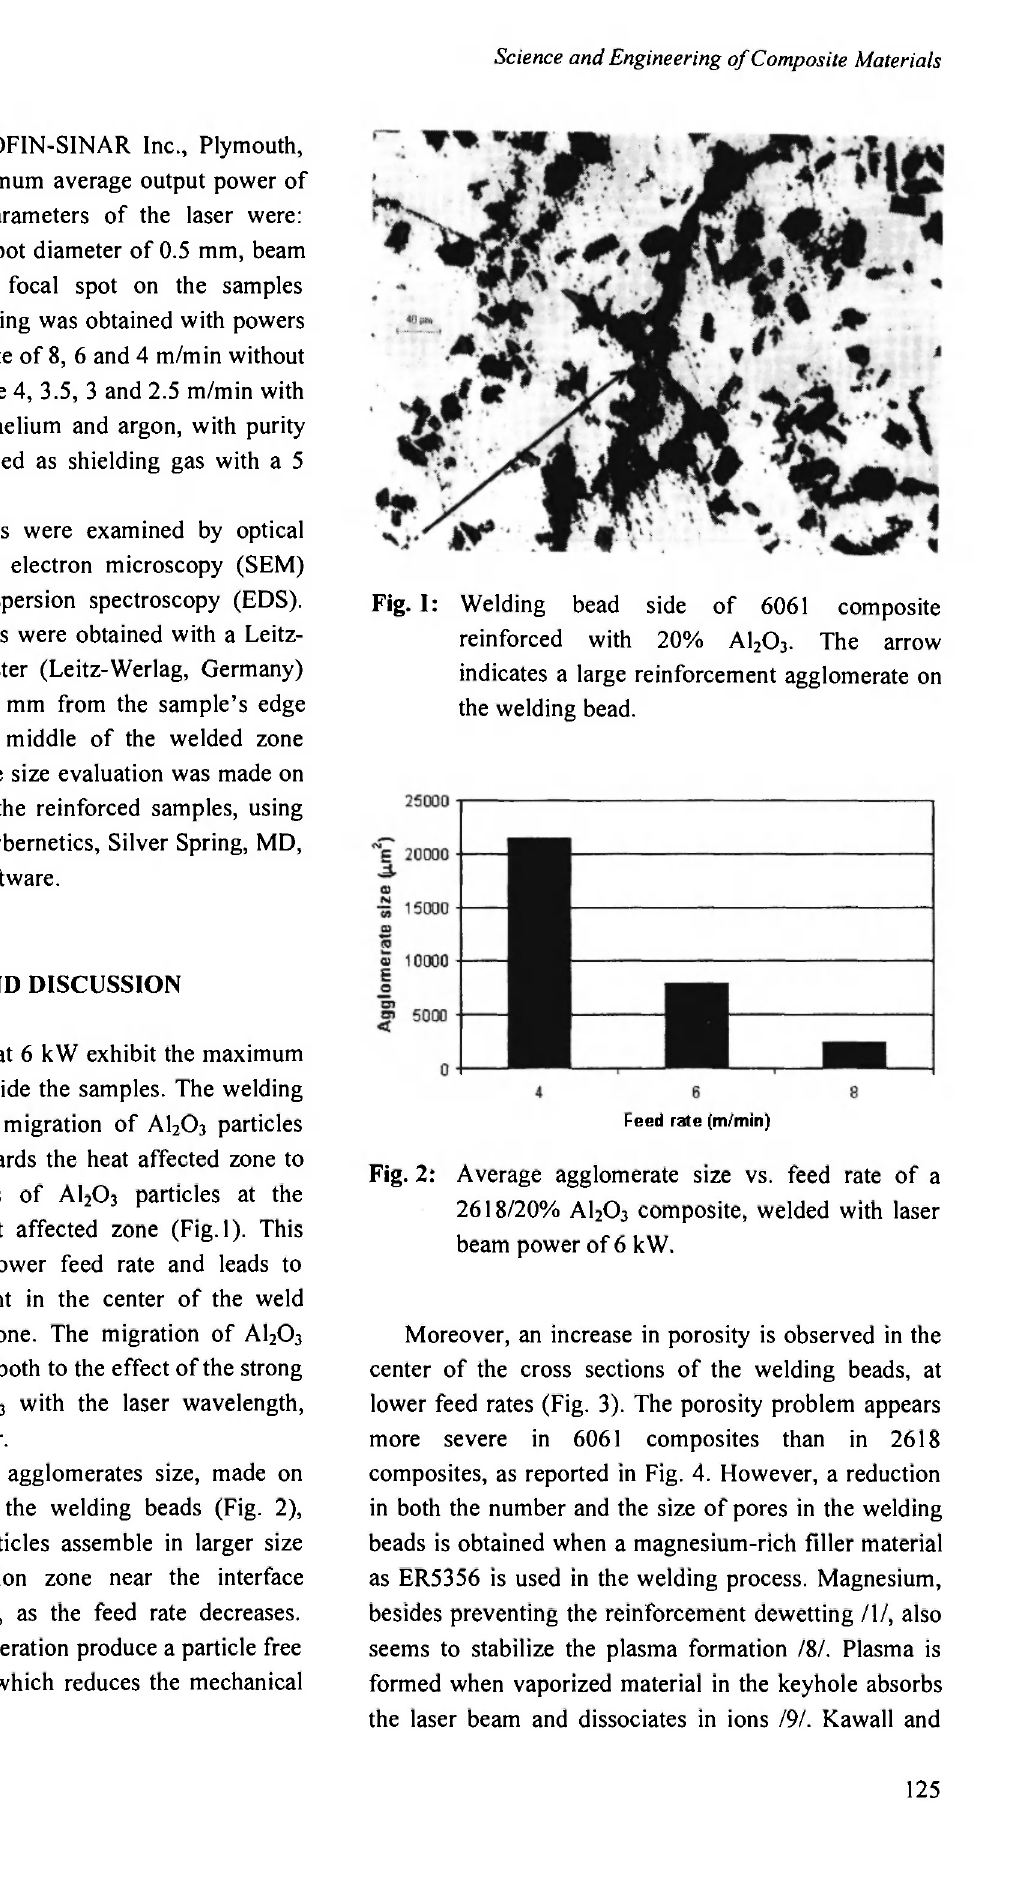
Fig. I: Welding bead side of 6061 composite reinforced with 20% A1 2 0 3 . The arrow indicates a large reinforcement agglomerate on the welding bead.